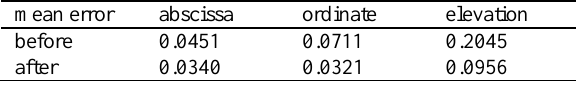
Table 1. Comparison of point cloud accuracy